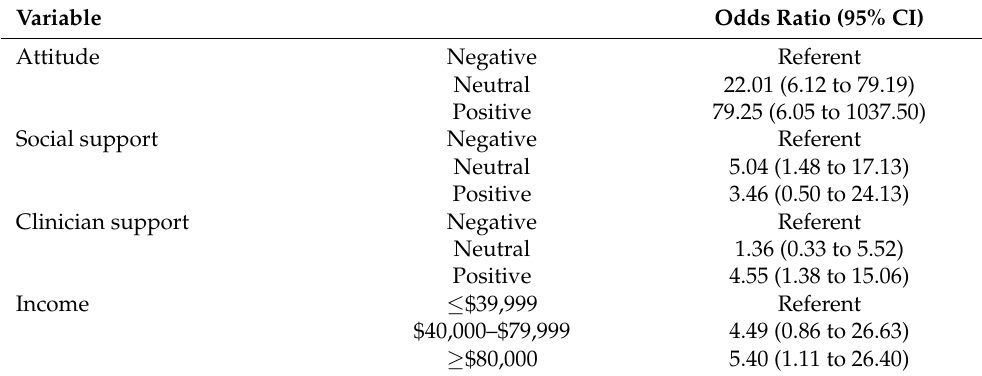
Table 2. Predictors of intention to vaccinate with the adjuvanted seasonal influenza vaccination (multivariate logistic regression model